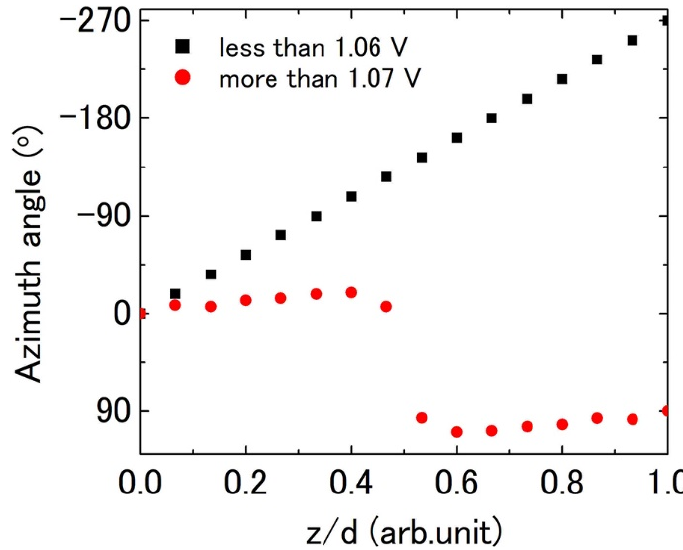
Figure 9. Azimuth angle dependence of the normalized cell thickness for LPSTN (MLC-2173, chiral